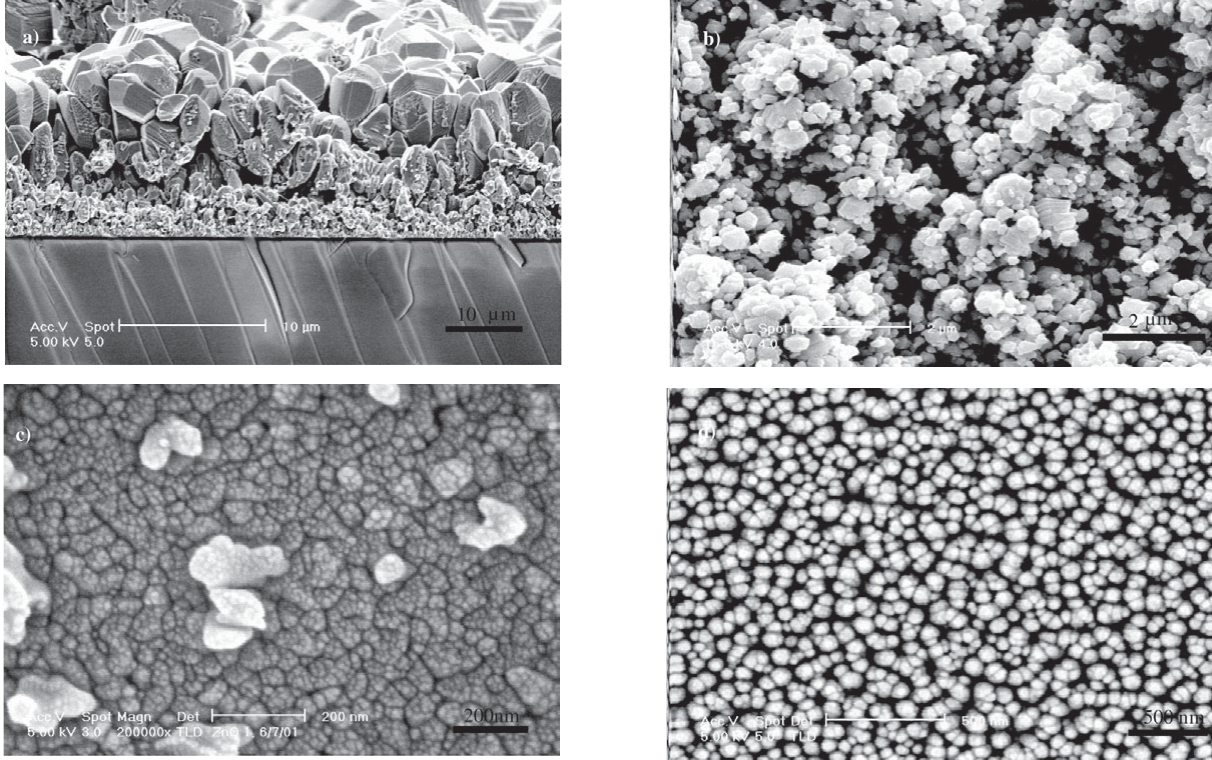
Figure 1 . Zinc and ZnO thin films formed with direct oxidation and magnetron sputtering, a) Zn cross-section, b) Zn + 1.2at.%Al surface morphology showing the effect of Al doping on the microstructure, c) ZnO formed through oxidation of Zn under Po for 24 hrs, and d) ZnO film with DC magnetron sputtering.